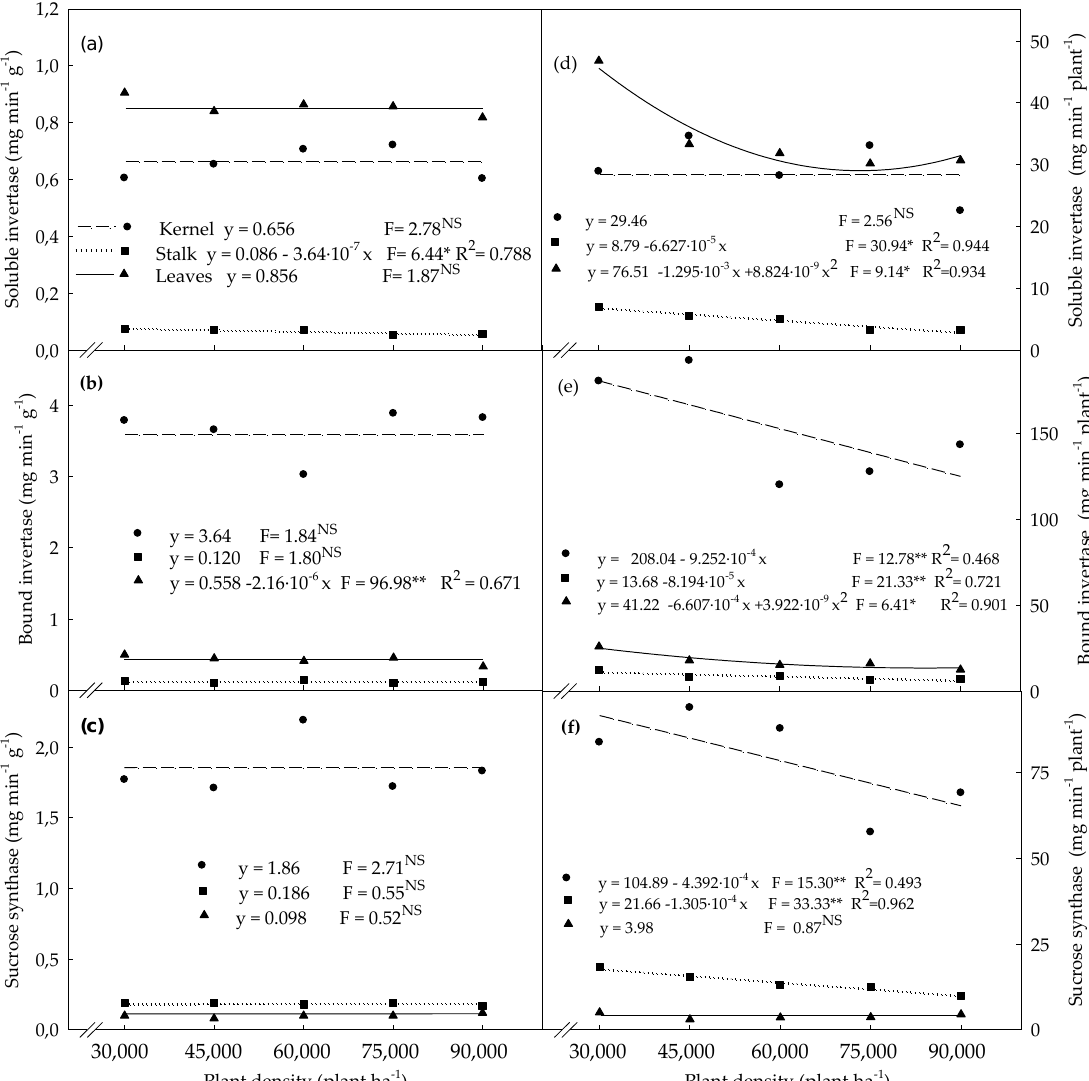
Figure 4. Specific activity of soluble invertase ( a ), bound invertase ( b ), and sucrose synthase ( c ), as well as activity per plant of soluble invertase ( d ), bound invertase ( e ), and sucrose synthase ( f ) in the kernel, leaf, and stalk of corn plants at the R4 stage as a function of the plant density ranging from 30,000 to 90,000 plants per hectare. Statistical data were obtained from four field replications. F = F test result of the regression analysis; (*) and (**) indicate that the F test revealed statistical significance at p ≤ 0.05 and p ≤ 0.01, respectively; R 2 = determination coefficient.